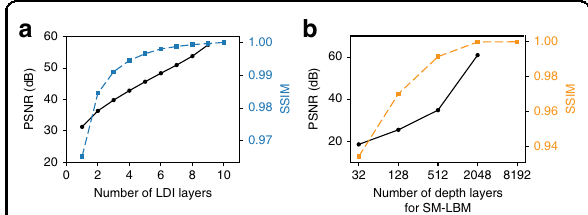
Fig. 2 SM-LBM hologram quality as a function of LDI layers and depth discretization. a The addition of more LDI layers provides diminishing returns on the hologram fi delity and the improvement plateaus after 5 layers. b A depth resolution over 11 bits (2048) results in a negligible difference in the image